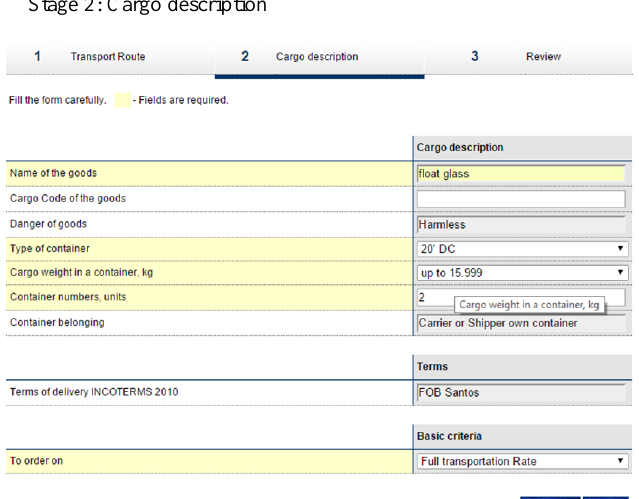
Fig. 7. On-line transport